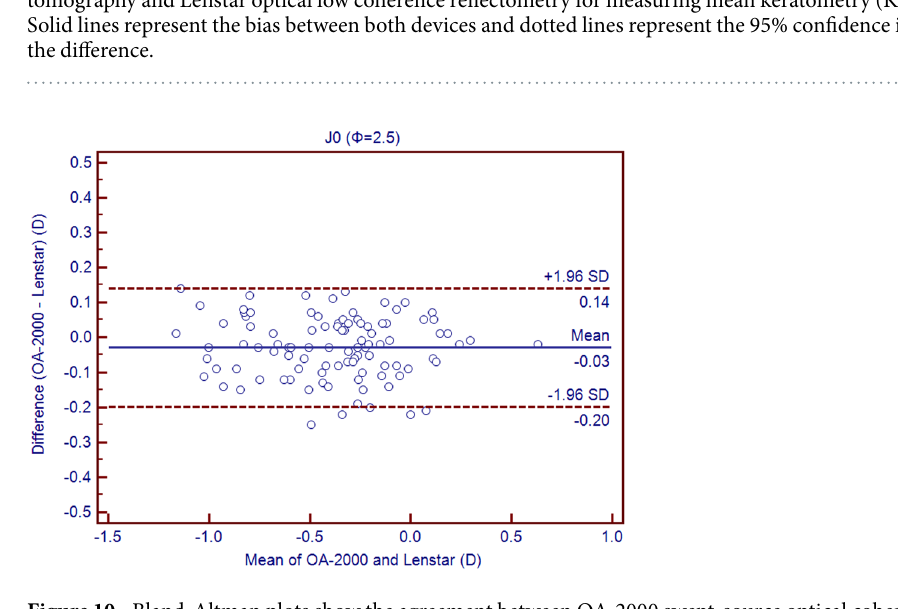
Figure 10. Bland-Altman plots show the agreement between OA-2000 swept-source optical coherence tomography and Lenstar optical low coherence reflectometry for measuring vectors J 0 at 2.5 mm. Solid lines represent the bias between both devices and dotted lines represent the 95% confidence interval for the